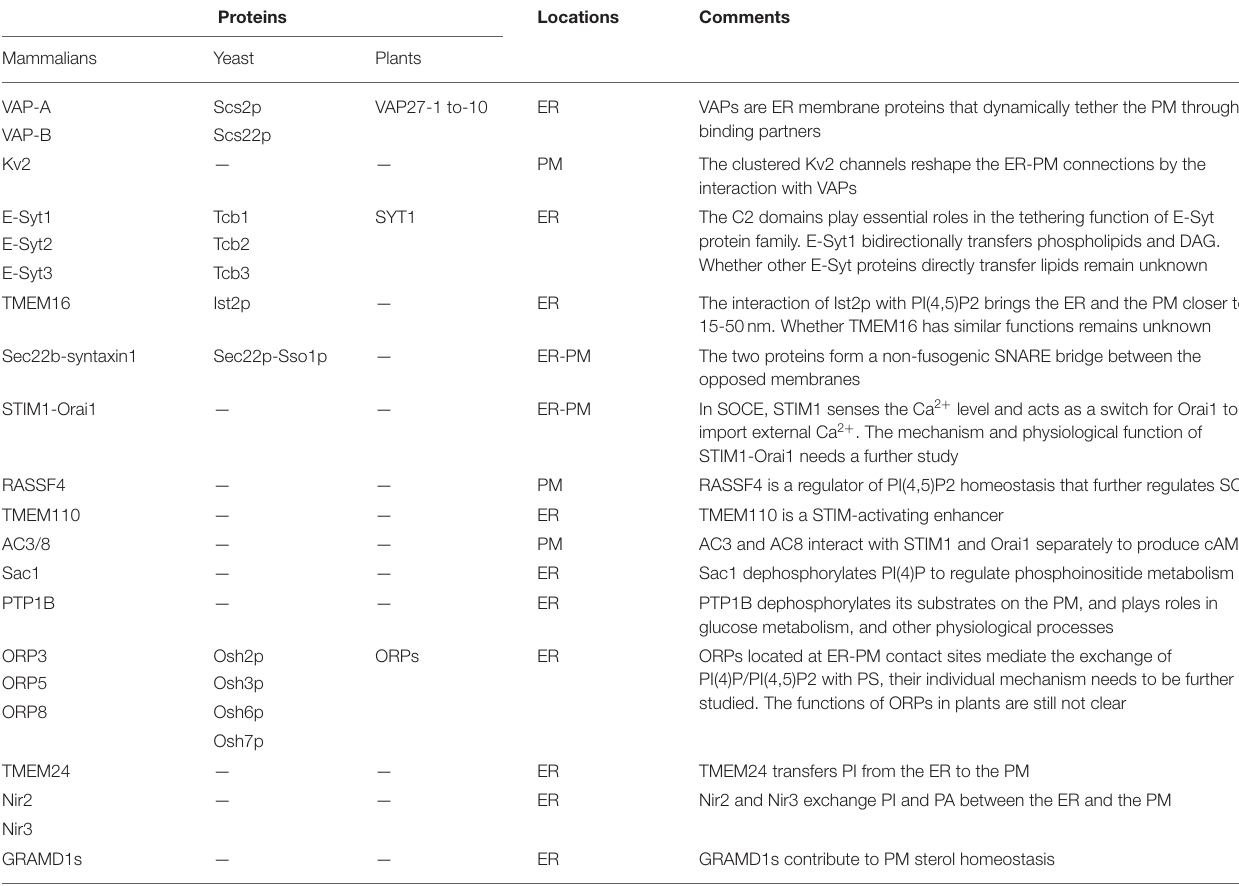
TABLE 1 | Summary of the proteins functioned at ER-PM contact sites. Proteins